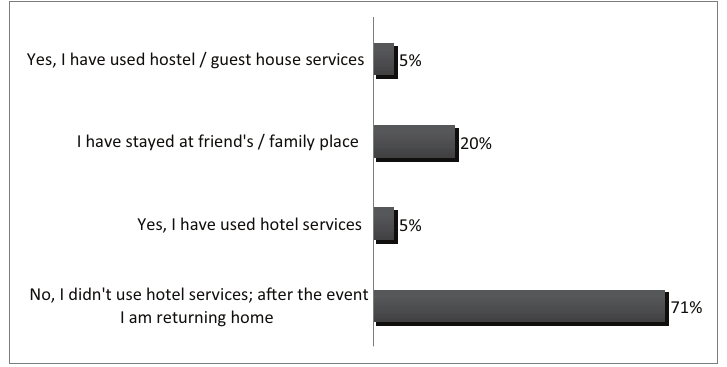
Fig. 2. If festival visitors have used hotel services